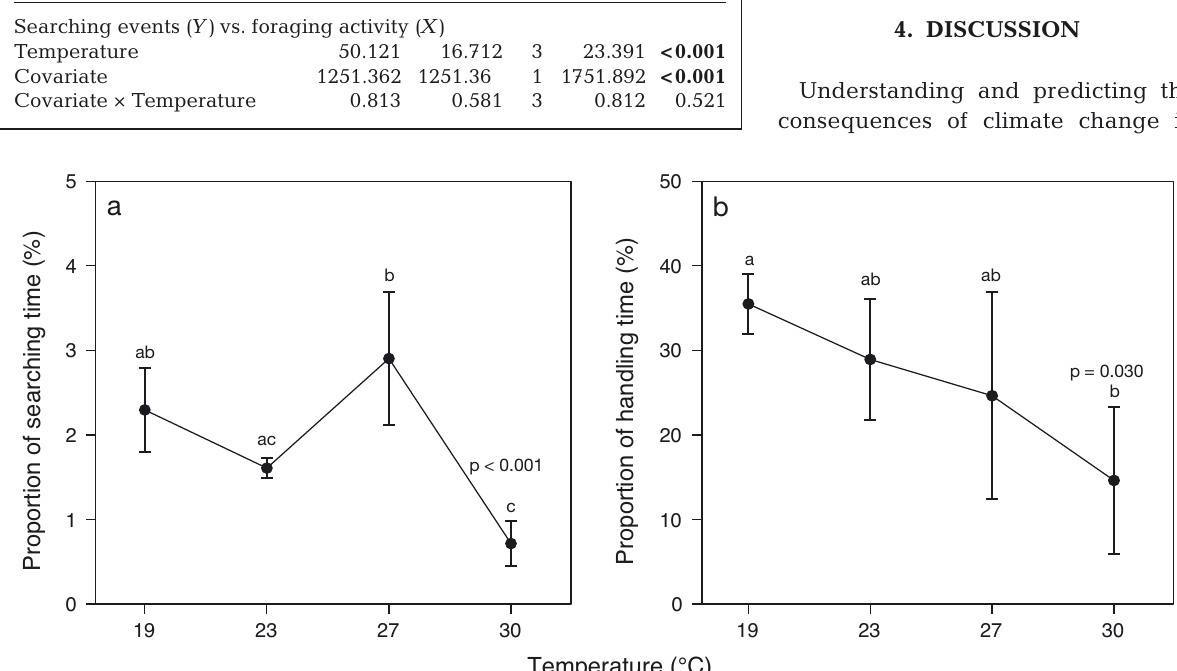
Fig. 4. Proportion of time that Rapana venosa spent on (a) searching and (b) handling under 19, 23, 27 and 30°C. All data are means ± SD, n = 4 for each temperature. Statistical significance (p < 0.05, 1-way ANOVA) is indicated by the p-value and different lowercase letters indicate significant differences between temperature groups. Note the different y -axis